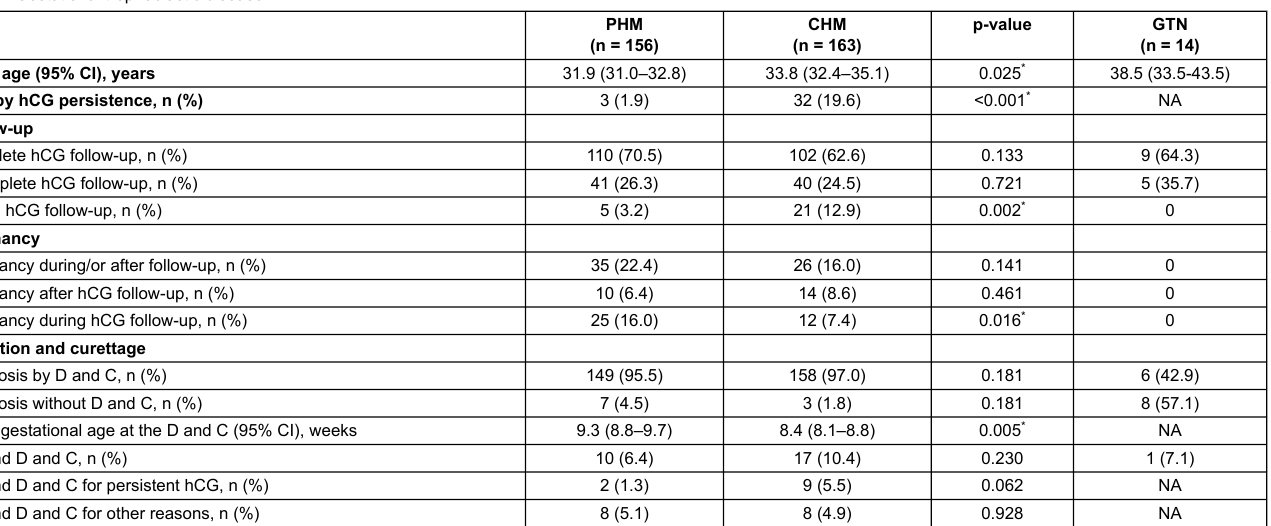
Table 2: Gestational trophoblastic